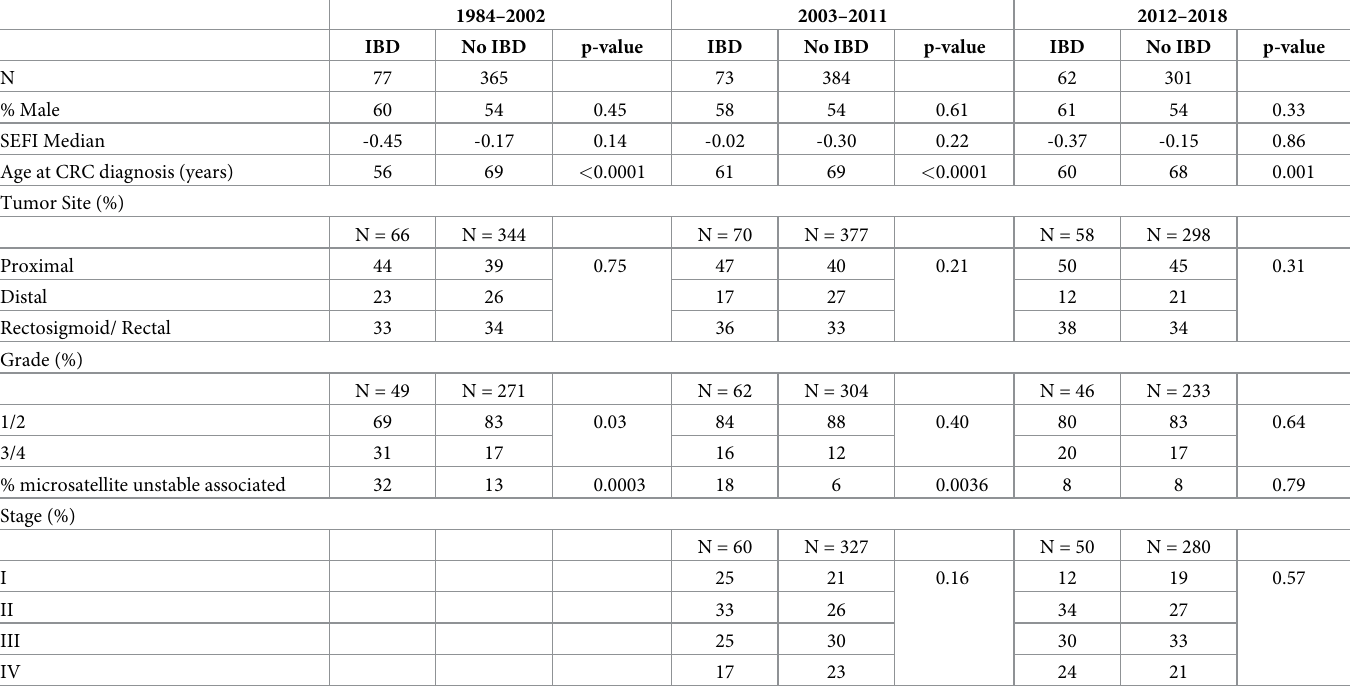
Table 2. Demographics of the study population with colorectal cancer stratified by era of diagnosis and IBD diagnosis �